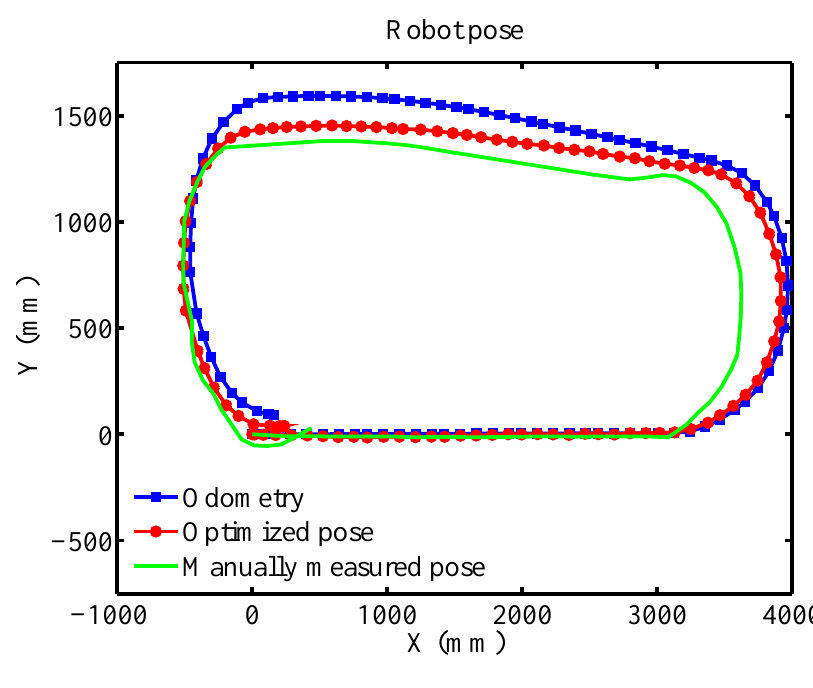
Figure 16. Experimental result for the robot’s pose.